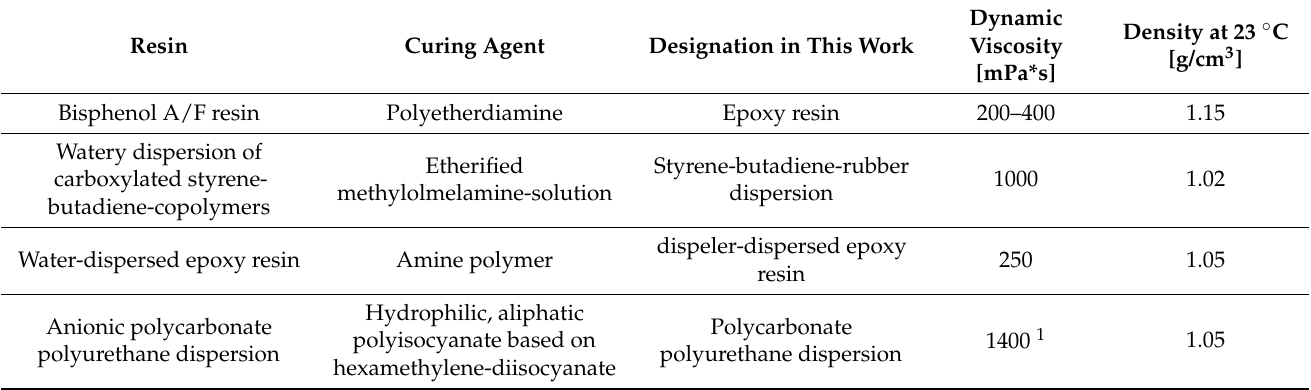
Table 3. Impregnation materials used in this